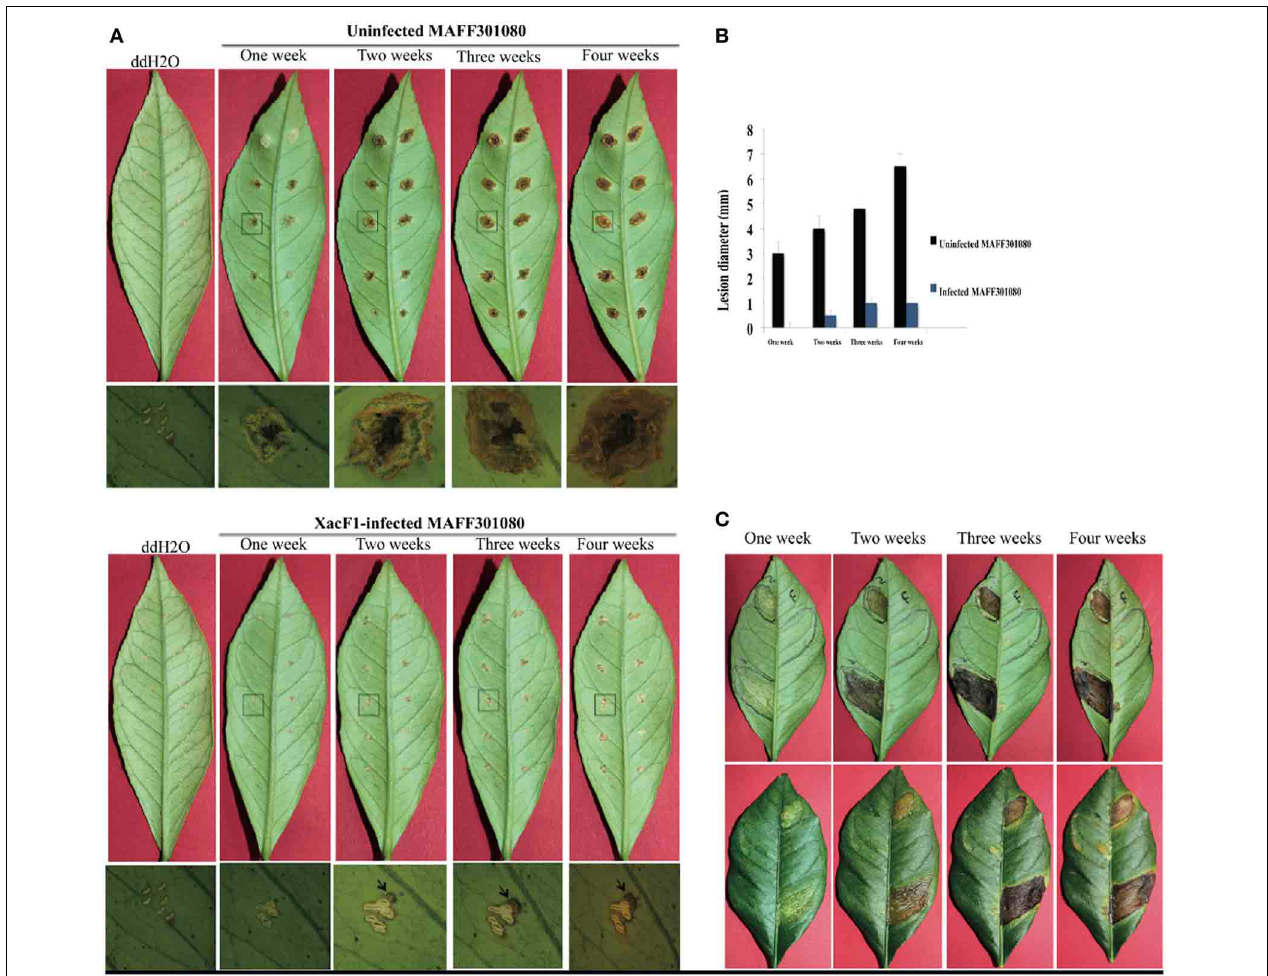
FIGURE 6 | Lesions on detached lemon leaves inoculated with cells of Xac MAFF301080. (A) Canker symptoms that had developed on leaves 1, 2, 3, and 4 weeks post-infection by the needle-pricking method. Leaves were inoculated with uninfected cells (upper panels) or XacF1-infected cells (lower panels). Leaf areas shown by a square were examined by photomicroscopy and the microscopic images are shown under each corresponding leaf. Characteristic canker lesions occurred with uninfected cells, while no obvious cankers developed on XacF1-infected cells. (B) Comparison of the size of